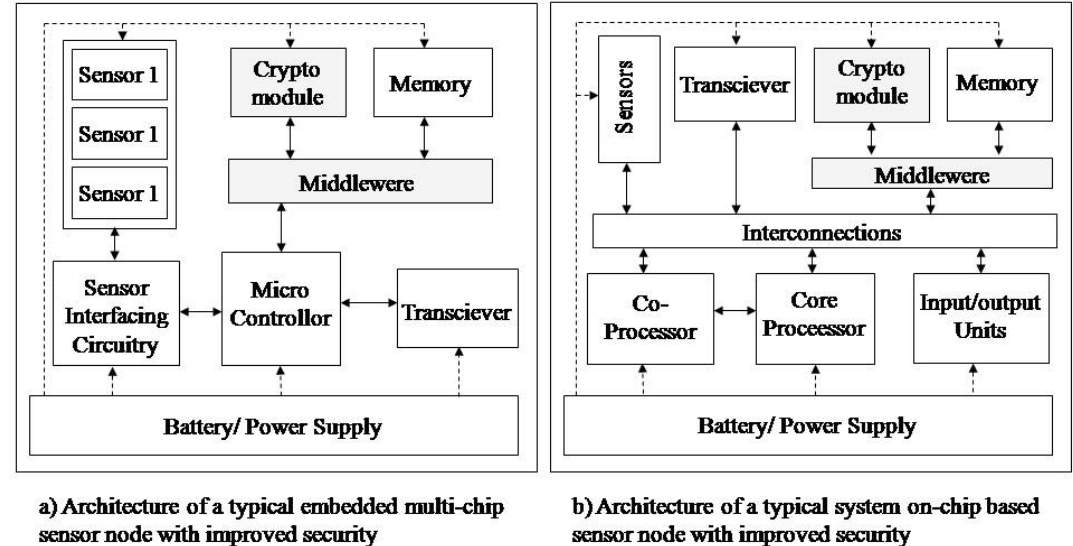
Figure 12. Extended hardware and software architecture of the sensor node.